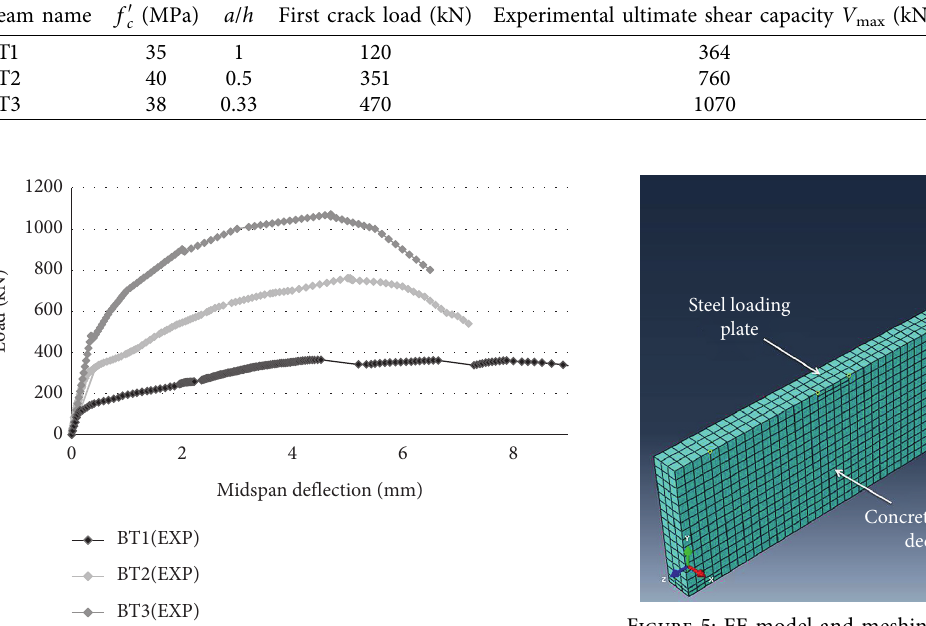
Figure 4: Load-deflection curves of test specimens.